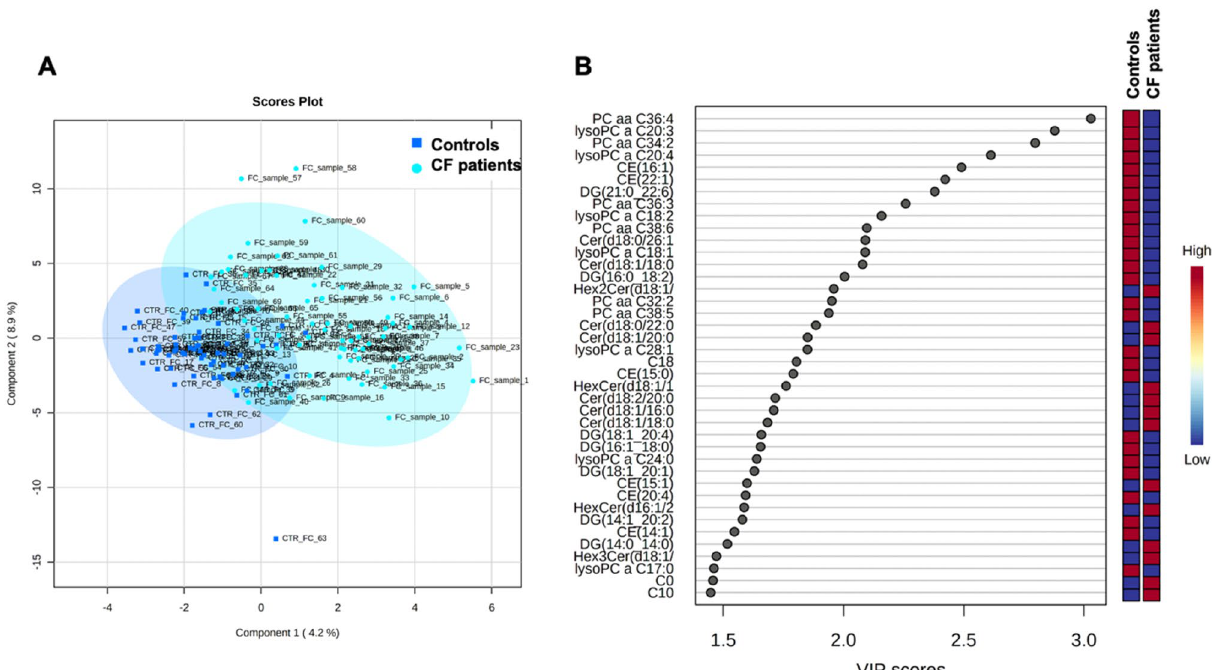
Figure 3. Descriptive discriminant analysis of the salivary lipidome of patients with CF. ( A ) The supervised partial least squares-discriminant analysis (PLS-DA) shows the binary segregation in CF and controls according to component 1 4.2% and component 2 8.9%. ( B ) The 36 most discriminant features identified according to the Variable Importance in Projection score (VIP > 1.5). The VIP score are assigned according to component 1. The intensity of the colored boxes represents the relative abundance in each group. The concentrations of the identified lipids were normalized, log(10) transformed, and Pareto